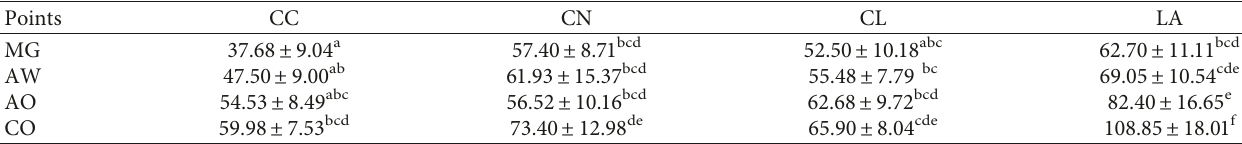
Table 3: Mean ( µ m) and standard deviation (SD) values for the different groups after fit measurement ( n � 10).